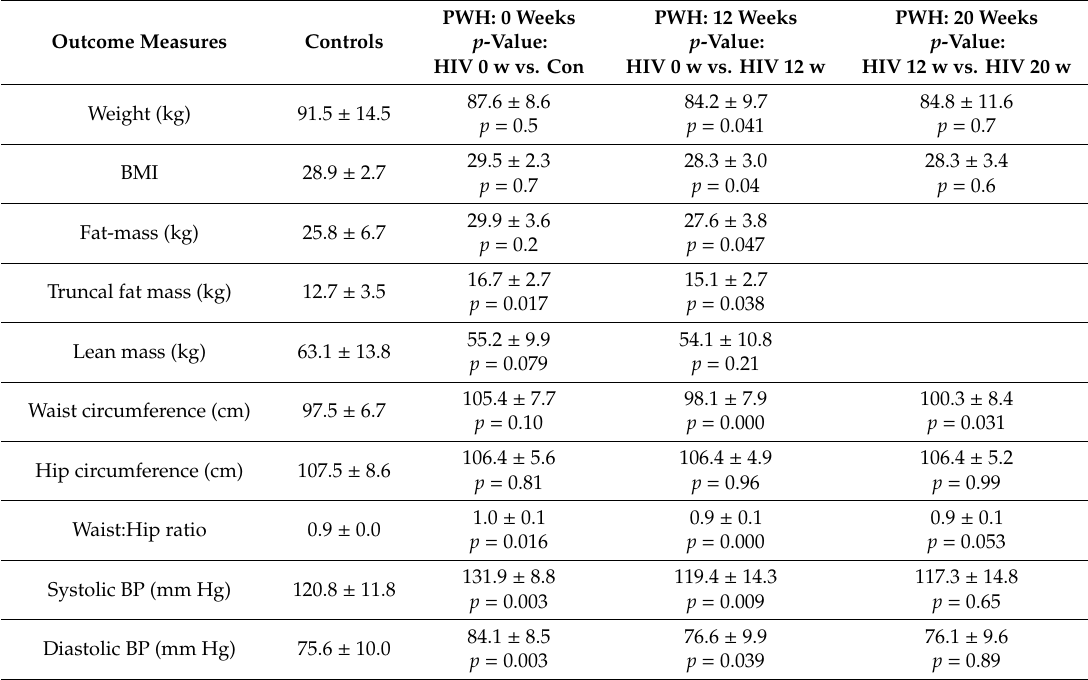
Table 8. Body composition and blood